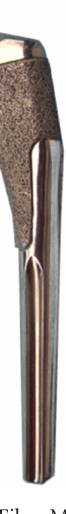
osteonecrosis of the femoral head for 18 hips, and rapidly destructive coxarthrosis for two